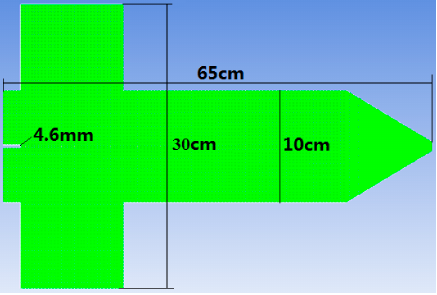
Figure 4. Mesh of the pressurized vitiated co-flow burner (PVCB).